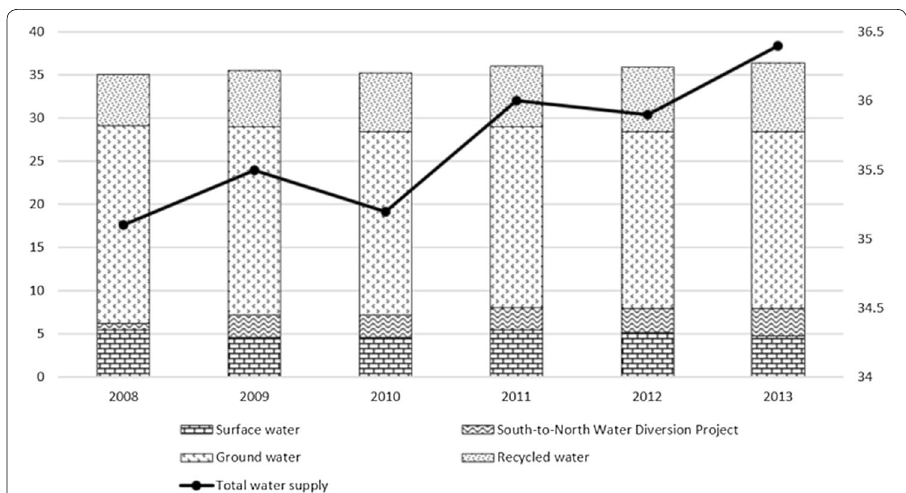
Fig. 1 Total water supply and structure of Beijing in 2008–2013 (billion cubic meters). Data source, Statistical Yearbook of Beijing Water Affairs